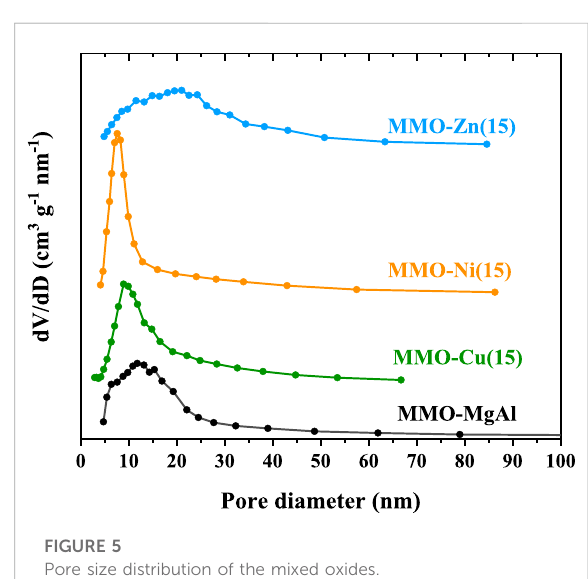
FIGURE 5 Pore size distribution of the mixed